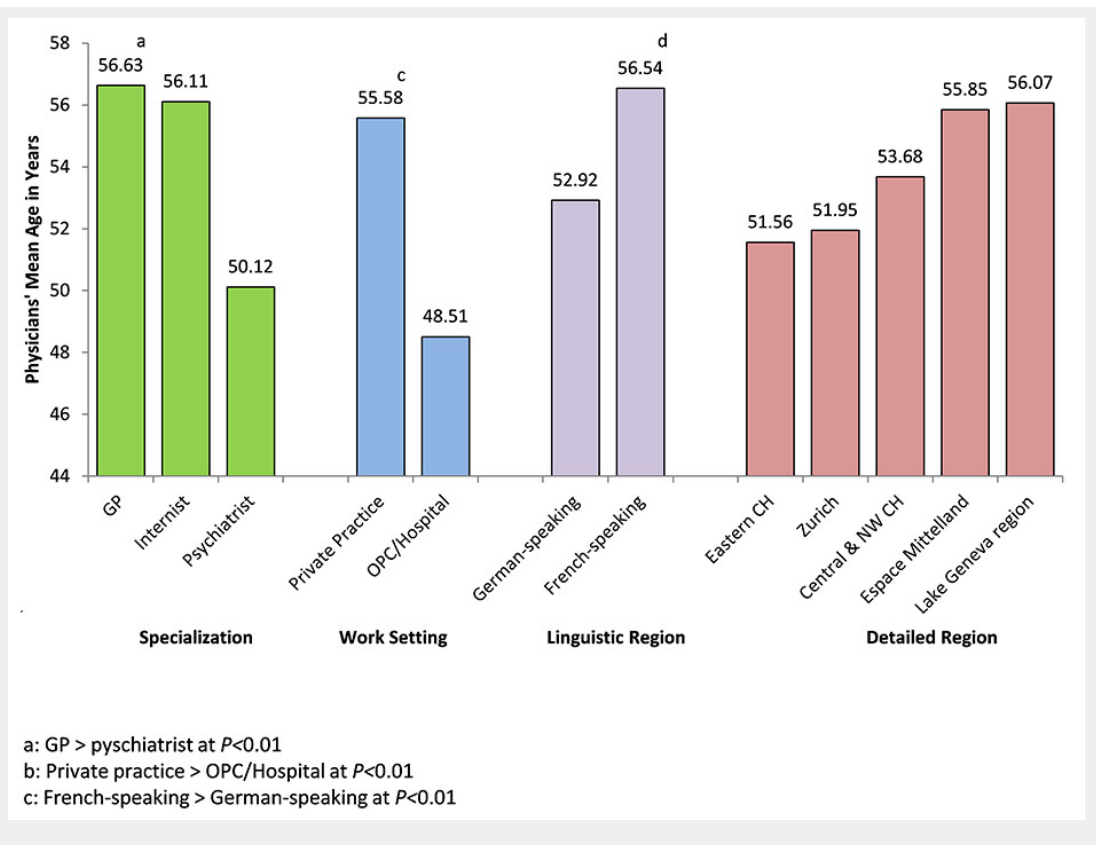
The age profile of the interviewed physicians by specialisation, work setting, linguistic region and detailed regional distribution. GP = general practitioner; OPC = outpatient